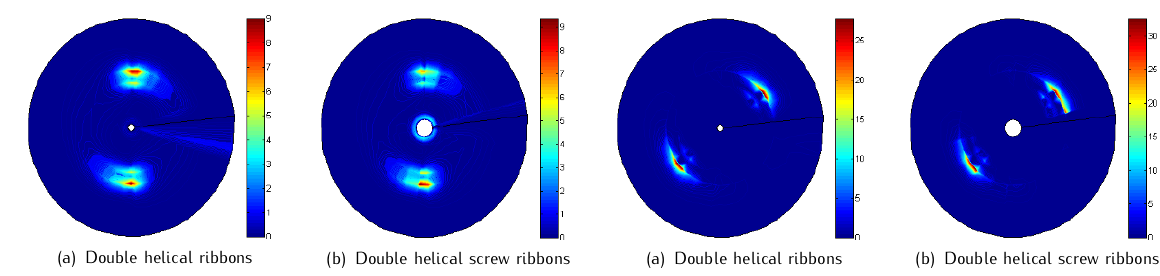
Figure 9. Dissipation rate induced in r-